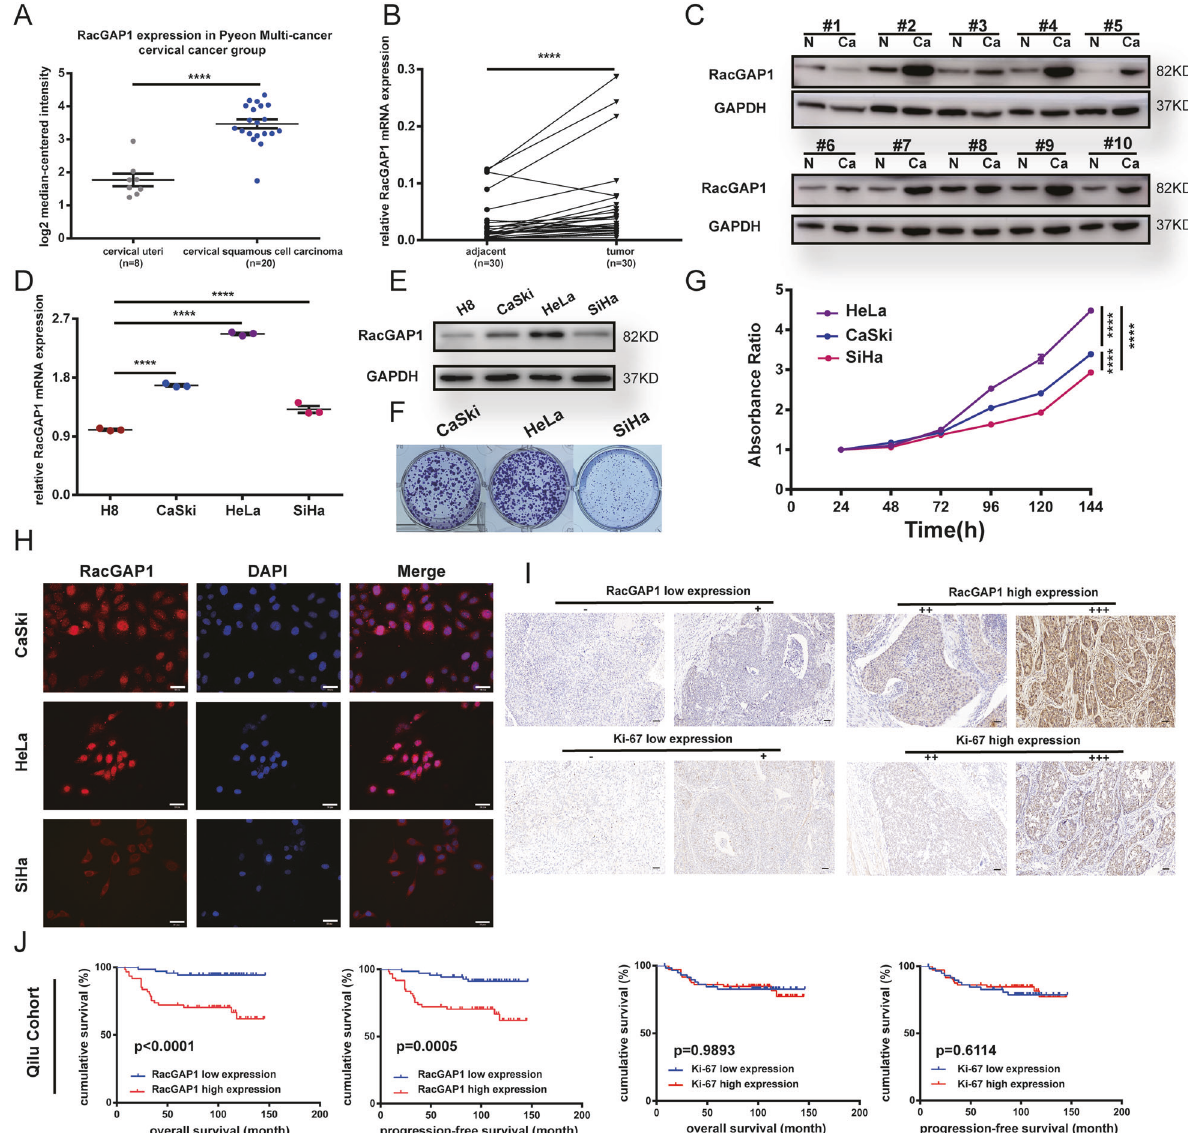
Fig. 2 Expression of RacGAP1 in specimens of cervical cancer patients and cell lines. A RacGAP1 mRNA was overexpressed in Pyeon Multi- cancer dataset from Oncomine database. B Expression of RacGAP1 mRNA in 30 cervical cancer specimens and paired adjacent normal tissues by qRT-PCR. Wilcoxon test of paired t test, p < 0.0001. C Expression of RacGAP1 protein in 64 cervical cancer tissues and adjacent tissues was analyzed by Western blot, using GAPDH as an internal control. D , E Analyses of mRNA and protein expression levels of RacGAP1 in cervical cancer cell lines compared with normal cervical epithelium cell H8. F Clone formation assay of three cervical cancer cell lines. G Cell proliferation was detected by CCK8 assays. H Immuno fl uorescence staining showed that RacGAP1 protein was expressed in three cervical cancer cell lines and was localized in both cytoplasm and nuclei. Scale bar = 20 μ m. I Representative RacGAP1 and Ki67 immunohistochemical staining in paraf fi n-embedded human cervical cancer tissues. (Magni fi cation, ×400). J Kaplan – Meier survival analysis (log-rank test) of the correlation between RacGAP1/Ki67 expression and OS/PFS in 131 cervical cancer patients. GAPDH glyceraldehyde 3-phosphate dehydrogenase, RacGAP1 Rac GTPase-Activating Protein 1, qRT-PCR quantitative real-time polymerase chain reaction, OS overall survival, PFS progression ‐ free